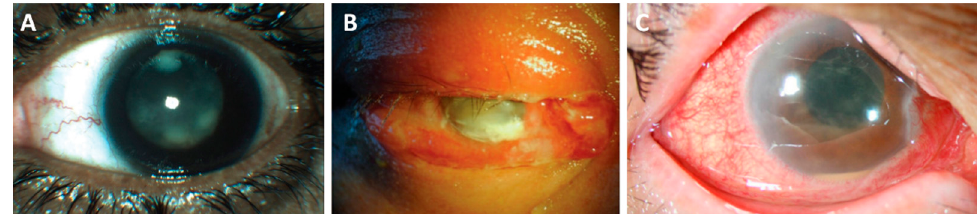
Figure 7. S.aureus, Bacillus , and E. faecalis endophthalmitis. ( A ) S. aureus endogenous endophthalmitis presenting with exudate behind the lens. ( B ) A patient with post-traumatic Bacillus endophthalmitis presents with chemosis, corneal opacification, periorbital swelling, proptosis, and a corneal ring